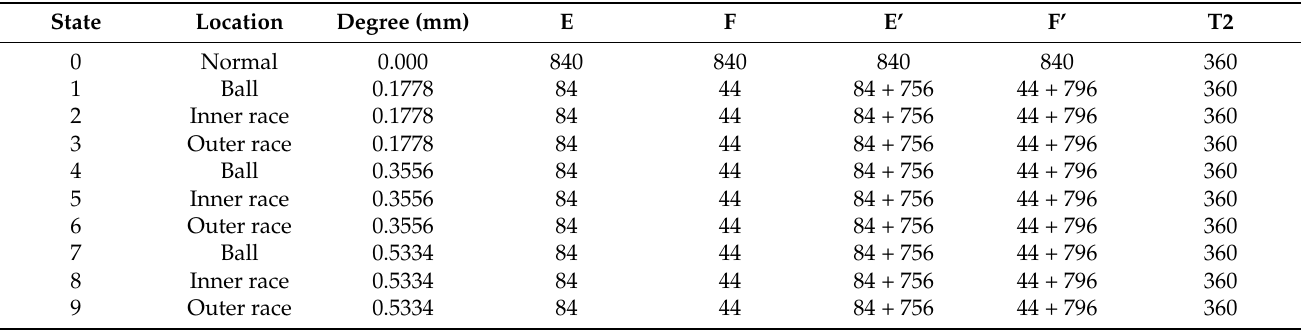
Table 5. The details of the experimental datasets, based on Case